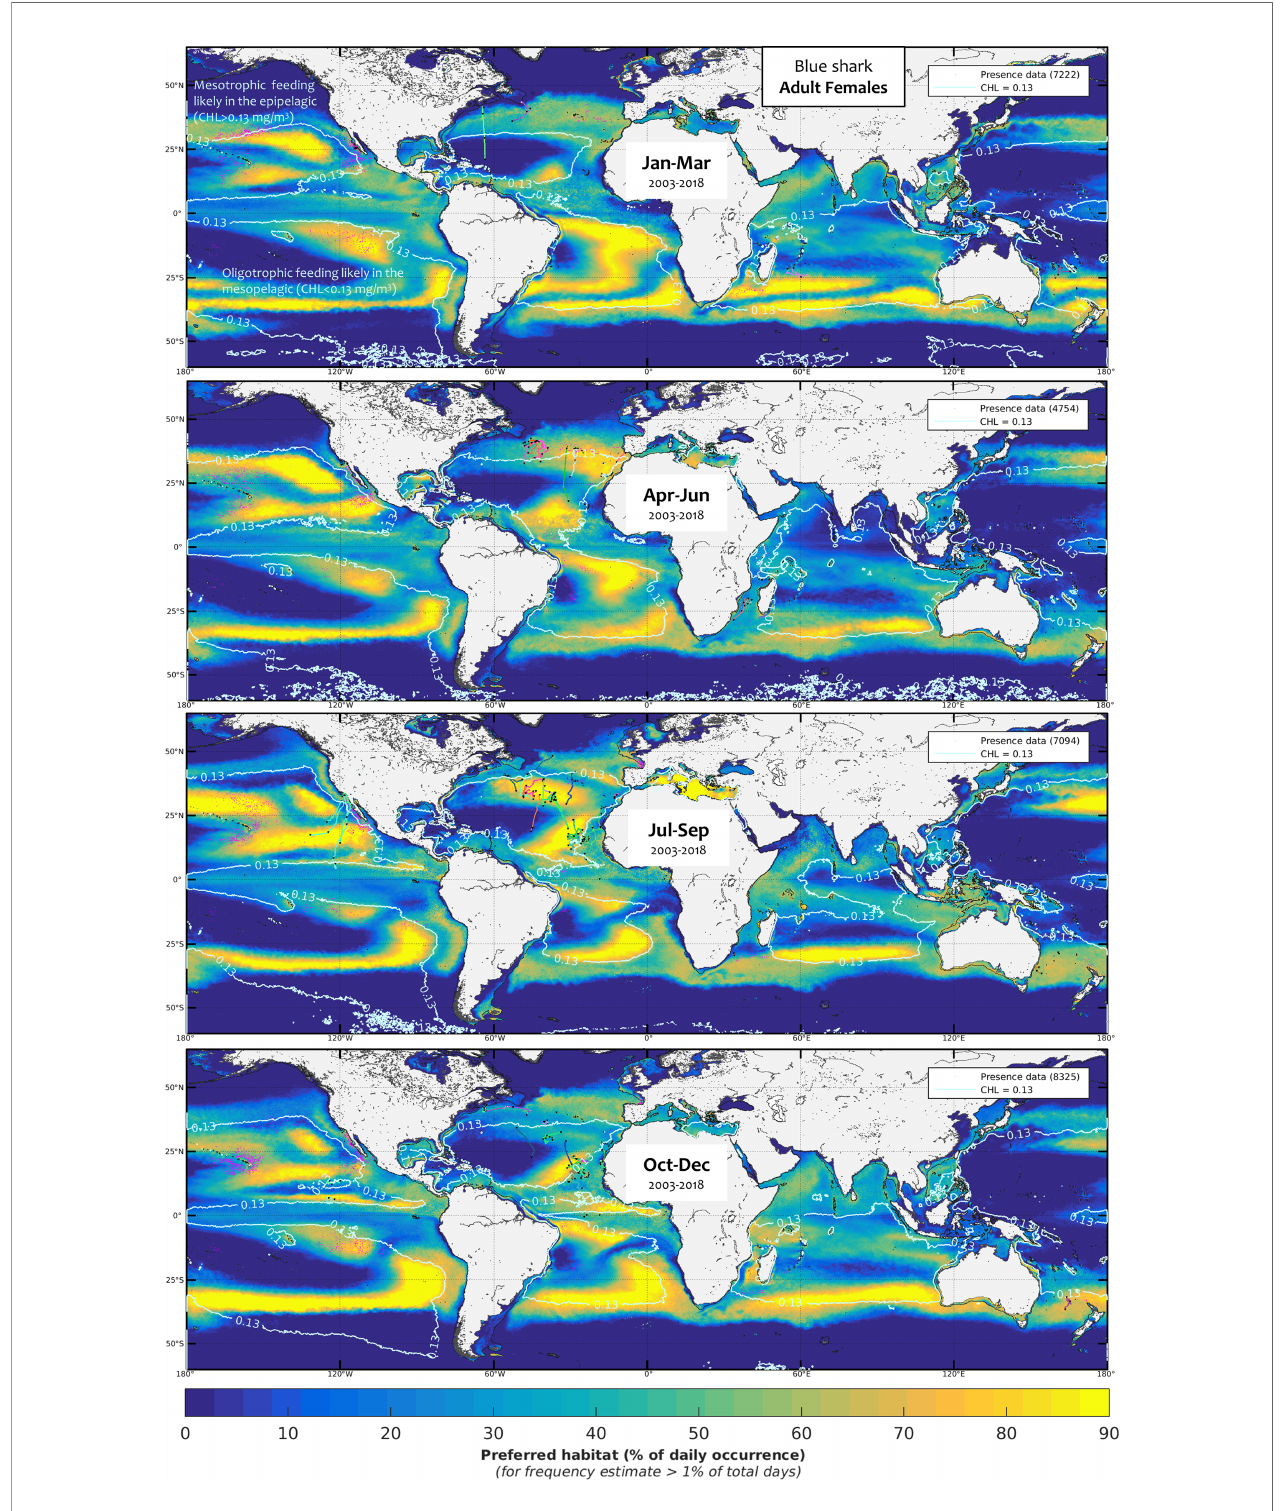
FIGURE 8 | Mean seasonal distribution of blue shark foraging habitat for the adult females (AF, 2003-2018, in frequency of suitable habitat occurrence, %). The chlorophyll-a isocontour of 0.13 mg.m -3 ( CHL min ) separates the mean area of oligotrophic foraging (below this value using mesopelagic micronekton as foraging proxy) and mesotrophic foraging (above this value using productivity fronts). Presence data (calibration and validation) are represented as pink dots for observer data and colored line transects for electronic tagging data (start and end of months are shown by a black